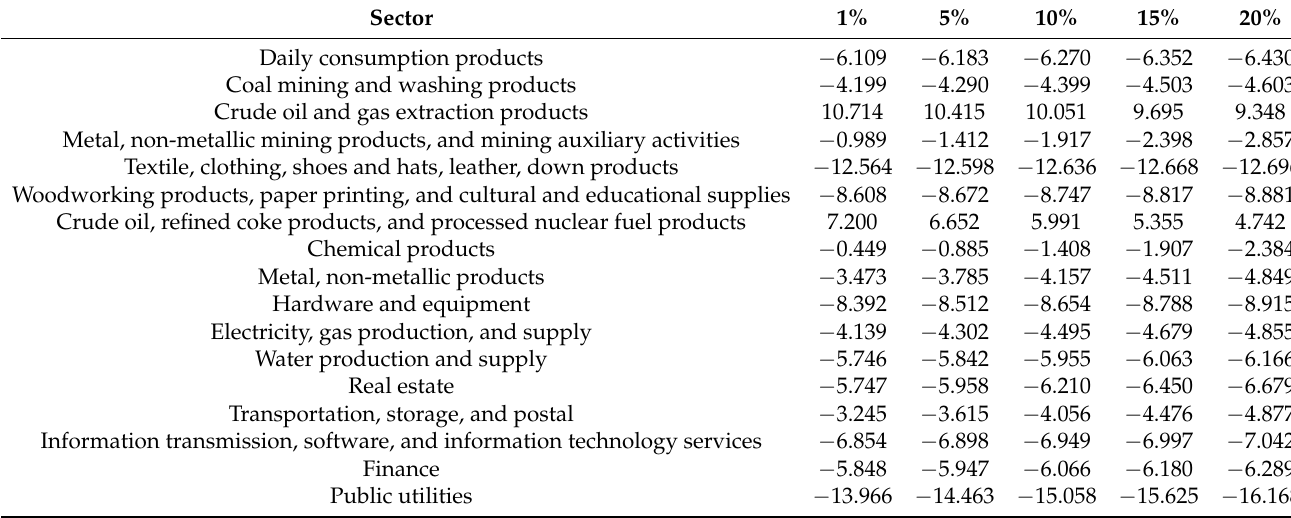
Table A15. The rate of change in investment after the rise in crude oil price.